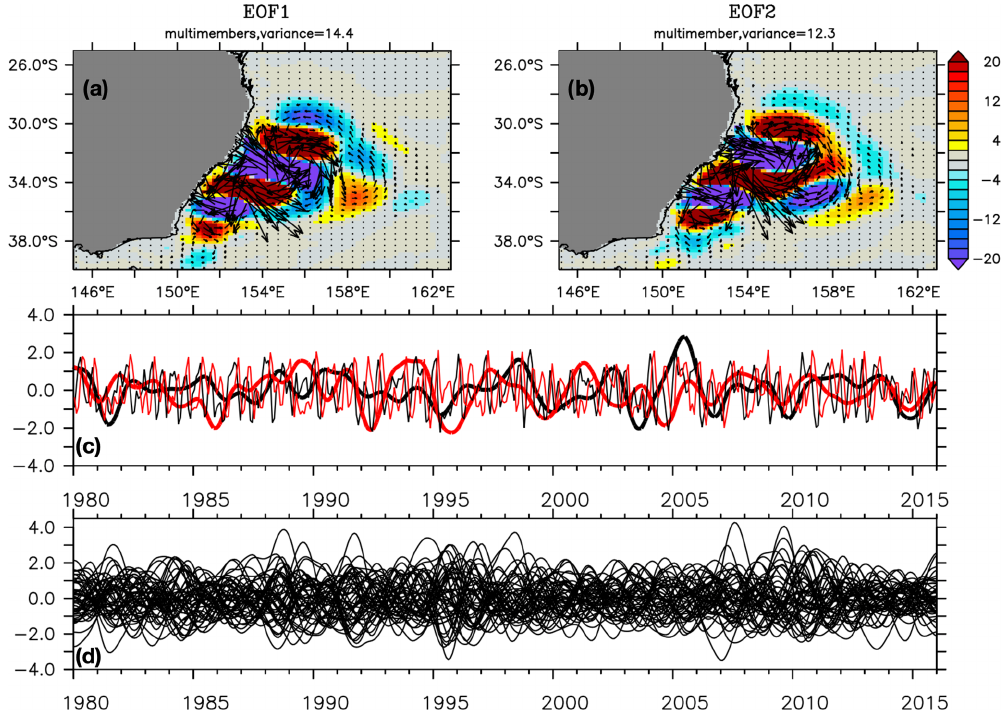
Figure 10. First (a) and second (b) spatial EOFs in the EAC region (25–40 ◦ S, 145–163 ◦ E) for the deviations of the 50 members from the ensemble mean of zonal and meridional transports considered as a single time series. (c) PCs of the first (black) and second (red) mode from monthly chaotic transports shown by thin lines and interannual chaotic transports shown by thick lines for member 1. (d) The PCs of the first mode from interannual chaotic transports of the 50